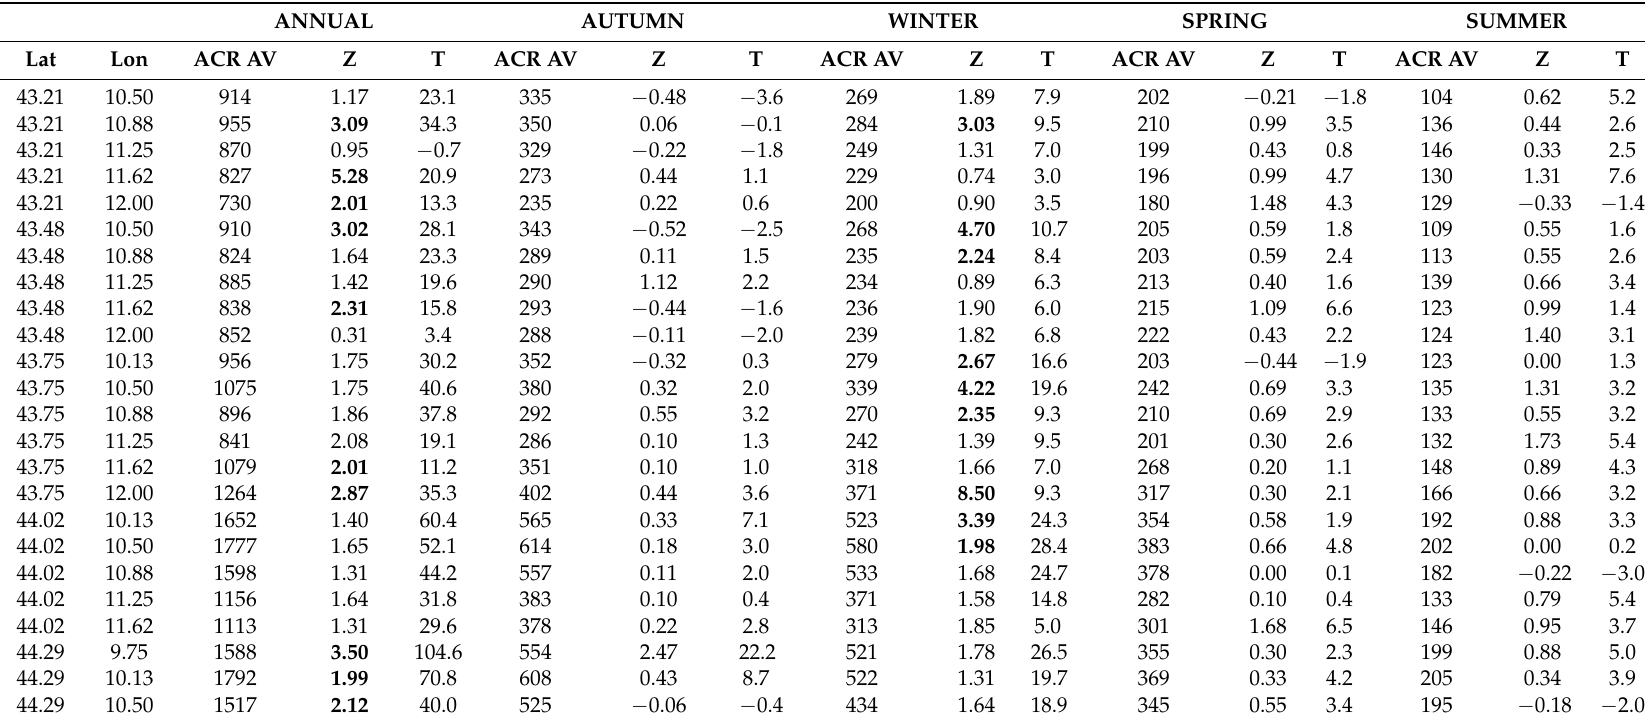
Table 3. Annual and seasonal ACR_AV estimates, values of Z statistic and magnitudes of the trend. The Z values >1.96 are reported in